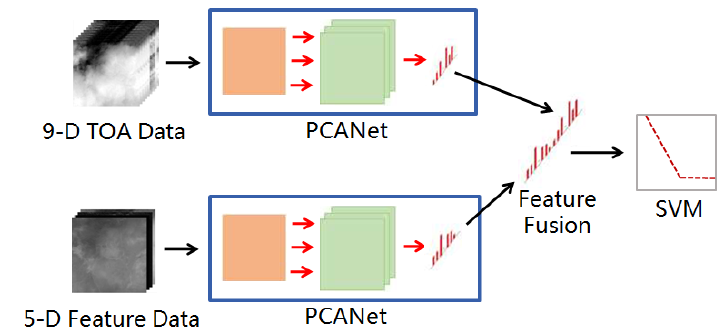
Figure 4. Flow chart of the cloud detection process based on